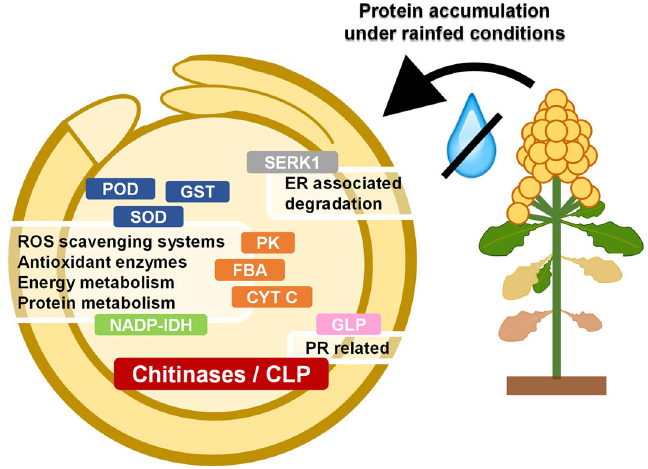
Figure 7. Schematic representation of the main proteins accumulated under rainfed conditions and their GO biological functions. Among the proteins accumulated under rainfed compared to irrigated conditions, there are proteins with functional GO annotations regarding POD: peroxidases (AUR62044027-RA, AUR62003342-RA, AUR62024052-RA, AUR62003343-RA, AUR62026666-RA, AUR62012343-RA, AUR62009723-RA); SOD: superoxide dismutase (AUR62000929-RA); GST: glutathione S-transferase (AUR62008599-RA); FBA: fructose- bisphosphate aldolases 3 (AUR62033531-RA, AUR62028580-RA); CYT C: cytochrome C (AUR62027049–RA, AUR62027048-RA); PK: plastidial pyruvate kinase 2 (AUR62021072-RA); NADP-IDH: NADP isocitrate dehydrogenase (AUR62002238-RA); SERK1: somatic embryogenesis receptor kinase 1 (AUR62018453-RA); GLP: germin-like protein (AUR62037551-RA); and the chitinases (AUR62021380-RA, AUR62021381-RA, AUR62027403-RA, AUR62023849-RA, AUR62002379-RA, AUR62031322-RA, AUR62027403-RA, AUR62023809-RA, AUR62003220-RA), including the two highly accumulated and exclusive chitinases/CLP (chitinase-like proteins) found in seeds under rainfed conditions (AUR62023849-RA and